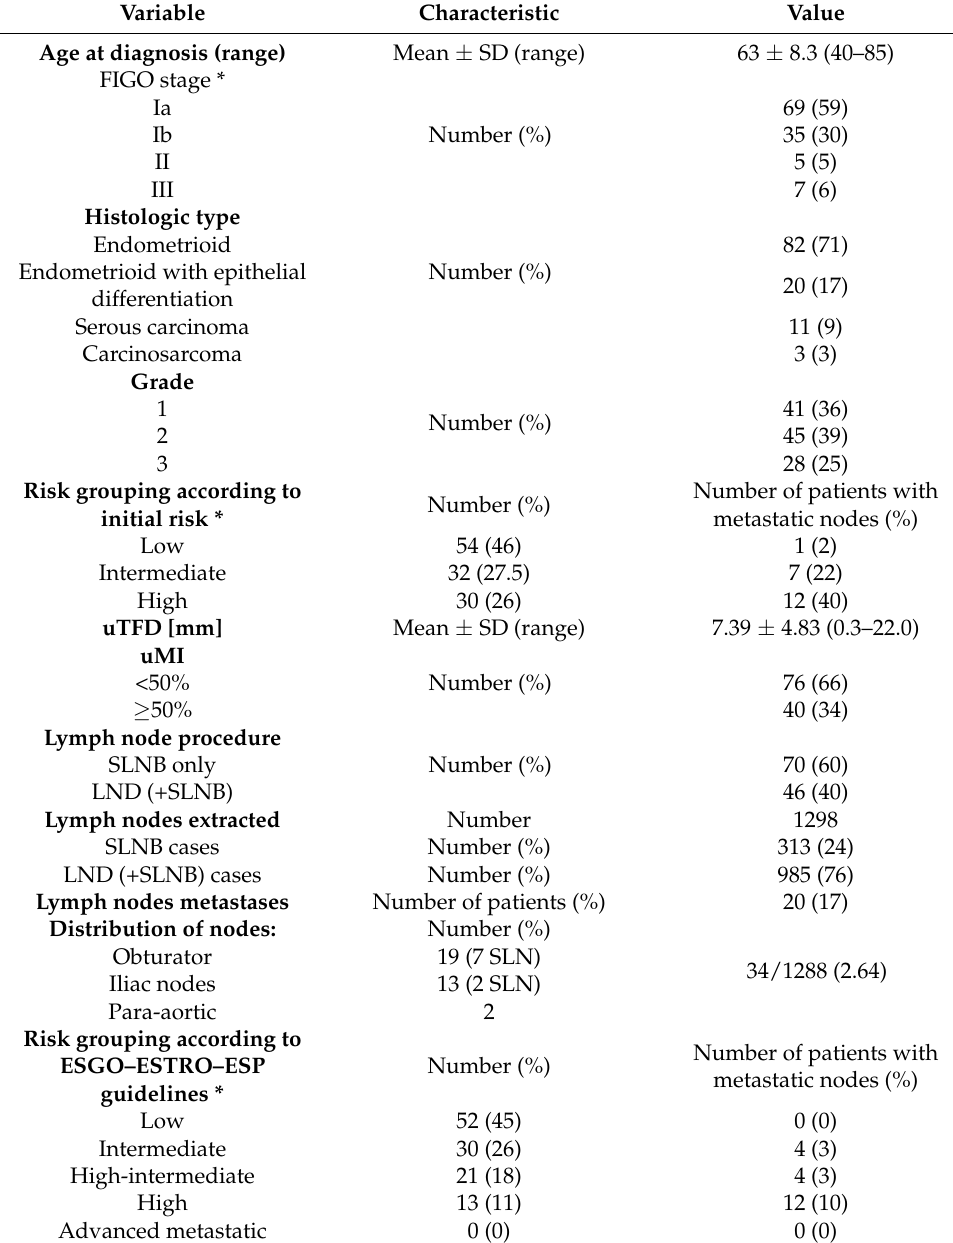
Table 1. Baseline characteristics of the study population (116